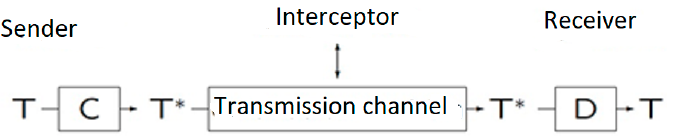
Figure 1. General scheme of transmission channel. T denotes the plain text (either natural language or reduced to a digit sequence for instant transcription). T* : cryptogram, or coded text (unreadable to anyone who does not know D). C : encryption or coding function, known by the sender. D : decryption or decoding function, known by the receiver.